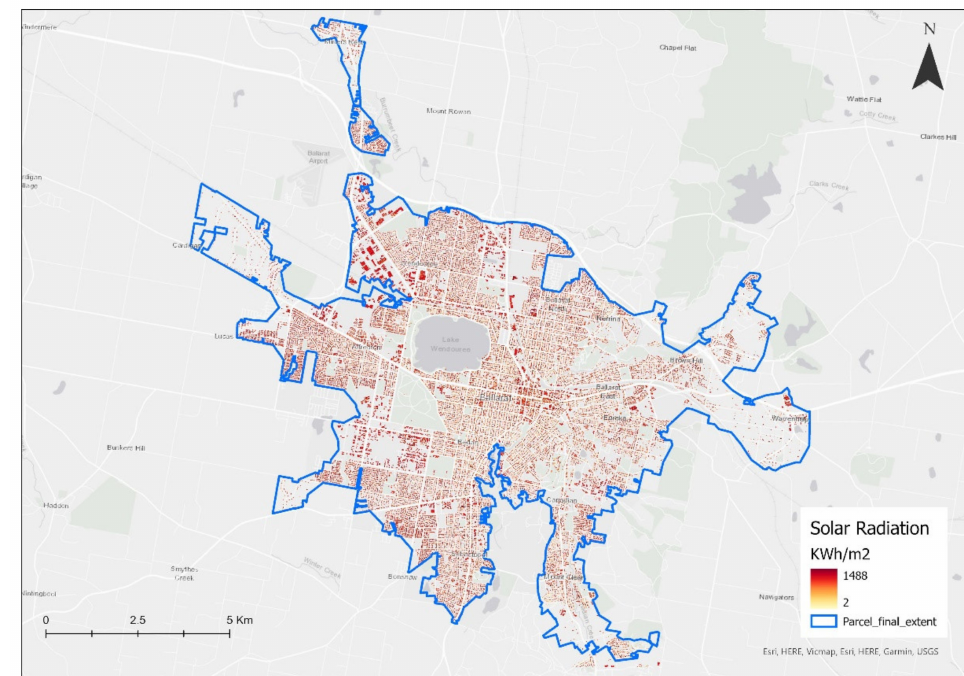
Figure A3. Spatial distribution of computed solar